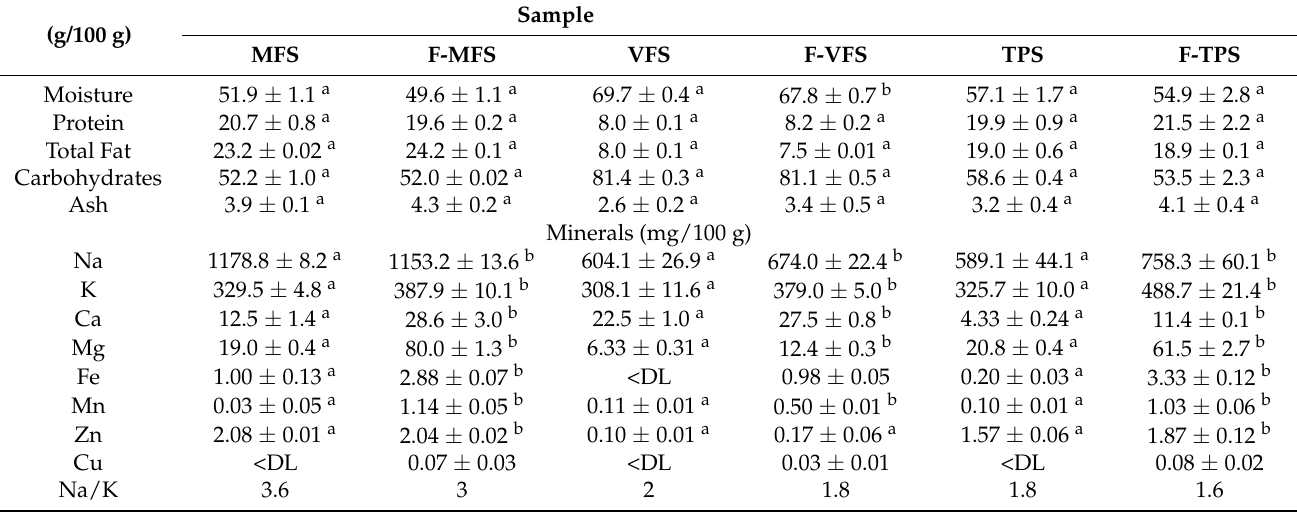
Table 1. Nutritional composition of plain and macroalgae-fortified